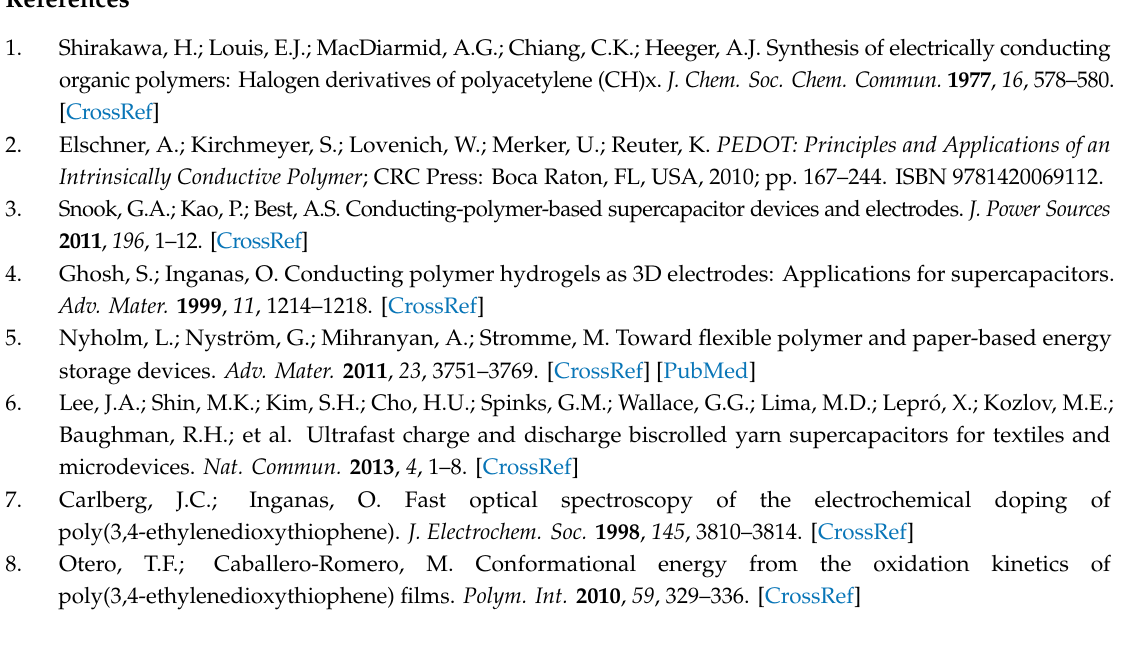
Figure S1: 1 H-NMR spectra of PDBProDOT, Figure S2: GPC traces of PDBProDOT, Figure S3: TGA curves of PEDOT:Triflate composite materials onto W substrates, Figure S4: TGA curves of polythiophene-derived composite materials, Figure S5: FTIR-ATR spectra of polythiophene-derivatives composite materials, Figure S6: FTIR-ATR spectra of PDBProDOT / cellulose microfibers composite material, Figure S7: Bulk conductivity dependence with frequency for selected cellulose composite materials obtained by in-situ polymerization, Figure S8: Bulk conductivity dependence with frequency for selected cellulose composite materials obtained by CPs solutions, Figure S9: σ s and σ trends on Sa roughness, Figure S10: Sa values of raw substrates and selected composite materials, Table S1: T50, T5 and % residue for cellulose substrates and composite materials, Table S2: σ , σ s and Sa of composite